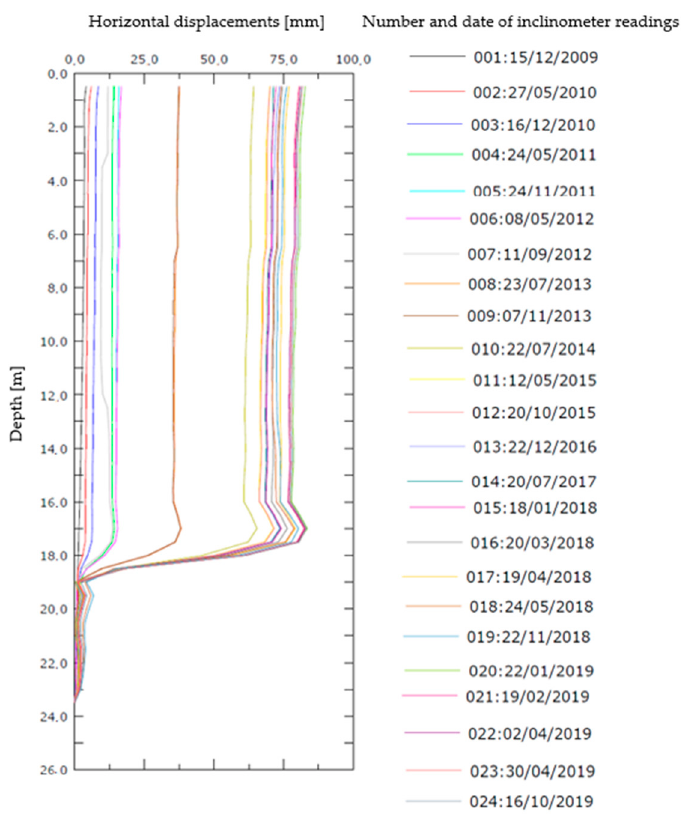
Figure 11. ( a ) 3D model of the slope with the church load; ( b ) Comparison between the detected stratigraphy profile (image above) and the numerical model cross-section (image below).